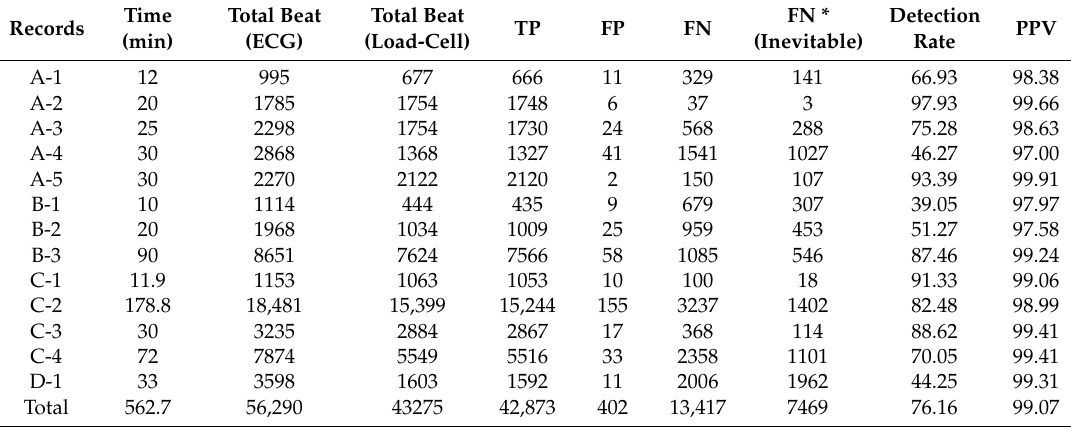
Table 3. Performance evaluation results with respect to the beat locations in HR analysis.